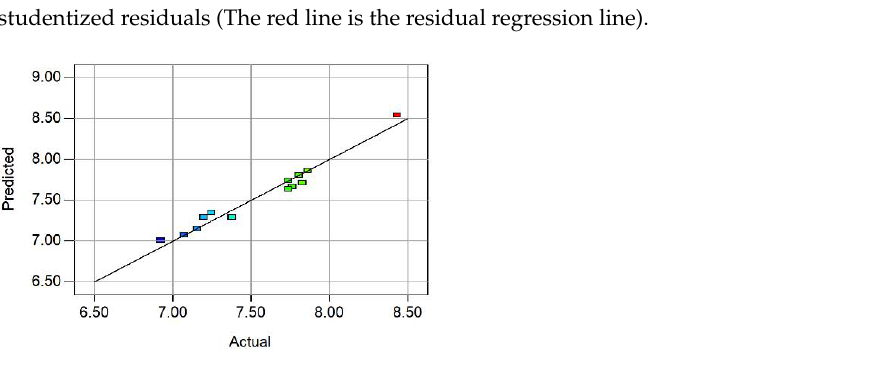
Figure 6. Comparison of calculated and predicted values (The black line is a 45 degree diagonal).